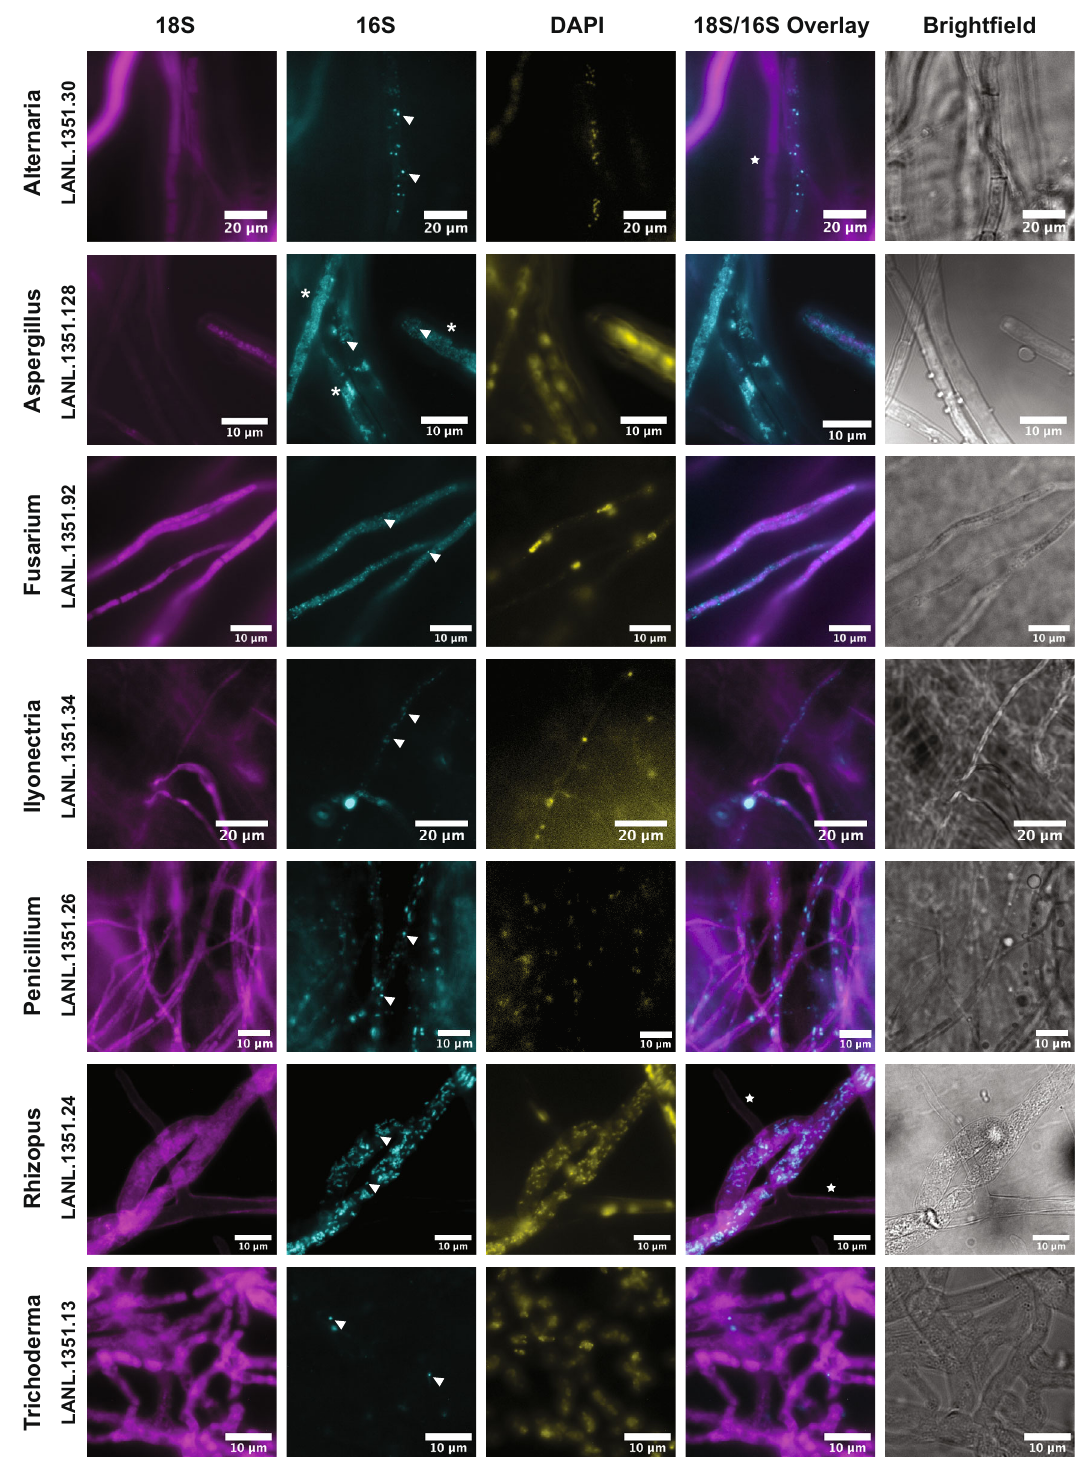
Fig. 4 Visualization of bacterial associates in diverse fungal hosts using 16S ribosomal RNA staining by fl uorescence in situ hybridization. Fungal ribosomes were stained using a universal eukaryotic 18S rRNA probe (magenta); bacteria were co-stained with a universal 16S rRNA probe (cyan); DAPI was used as a global nuclear stain (yellow). Overlays of the 18S and 16S fl uorescence show positive correlation of bacteria along or within hyphae. Observed bacterial signal was variable among fungal samples, and displayed coccoid and rod-shaped phenotypes. Individual structures resembling bacterial cells were observed (arrowheads) as were bio fi lm-like growth patterns along hyphae (asterisks). Bacterial structures absent in neighboring hyphae indicate variability in spatial distributions